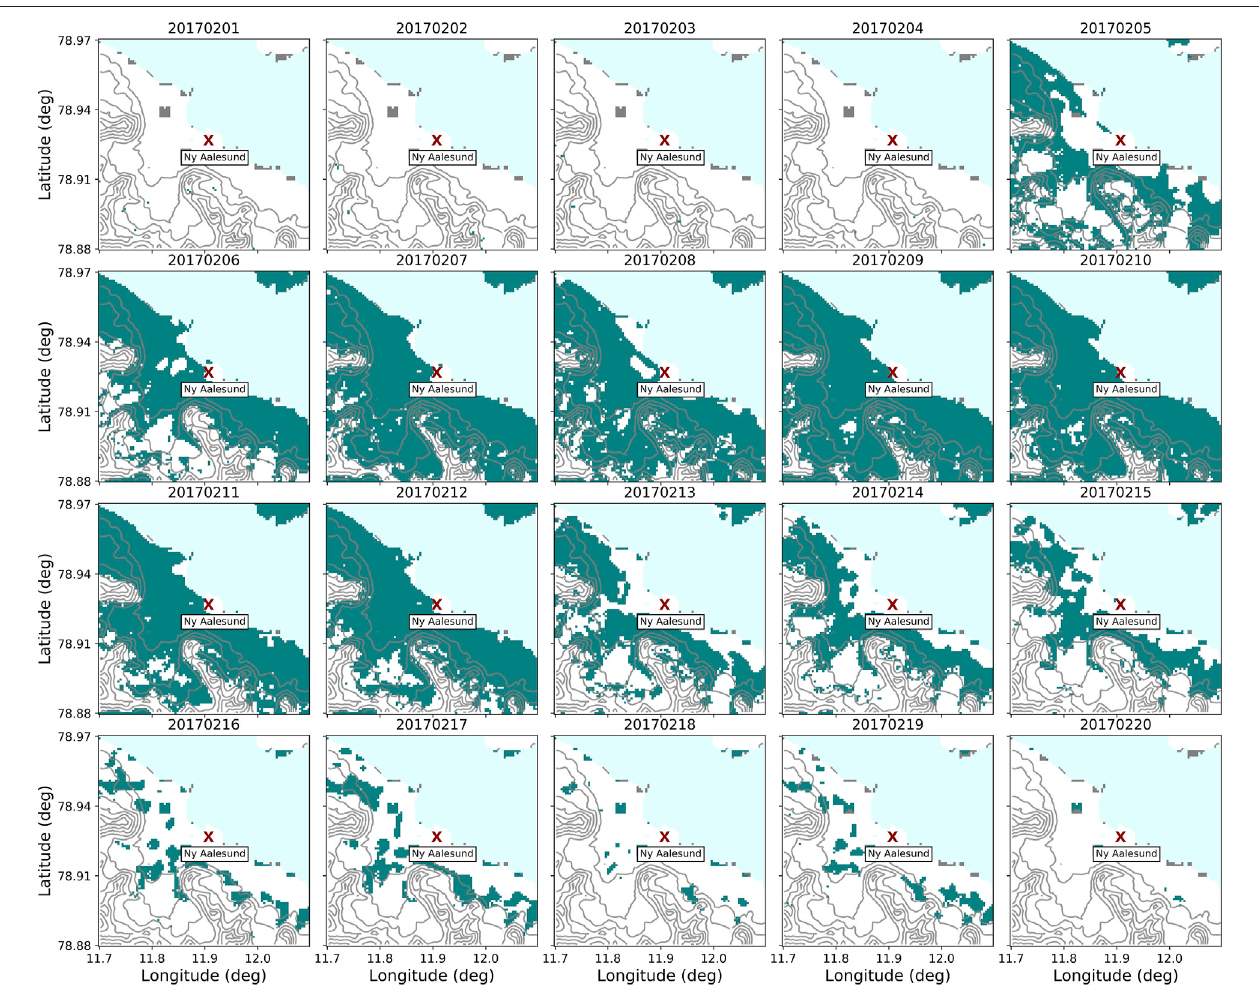
FIGURE 9 | Wet snow maps for a 10 km area centered on Ny Ålesund between 1 – 20 February 2017 during which a ROS event was registered in the meteorologicaldata.ElevationdataprovidedbyaDEMareshownbythecontourlinesshownat100 mheightintervals.White/uncolouredareasindicatedrysnowcover, whileteal-coloured pixels represent wet snowand greypixelsrepresentunclassi fi eddata.Thewetsnow mapsshow thetemporalchangesinspatial extentofwet snow during and after the ROS event, indicating that areas of wet snow can persist even after the precipitation has stopped.